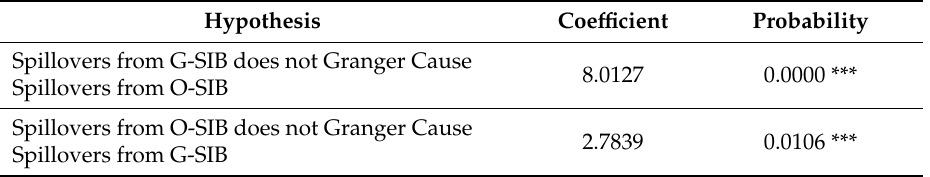
Table 10. Granger causality test for the systemic importance